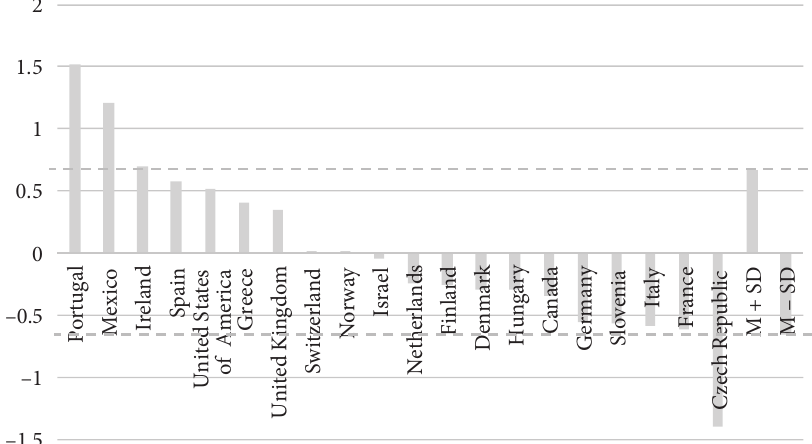
Figure 2. Individual effects for the TEA exploratory model